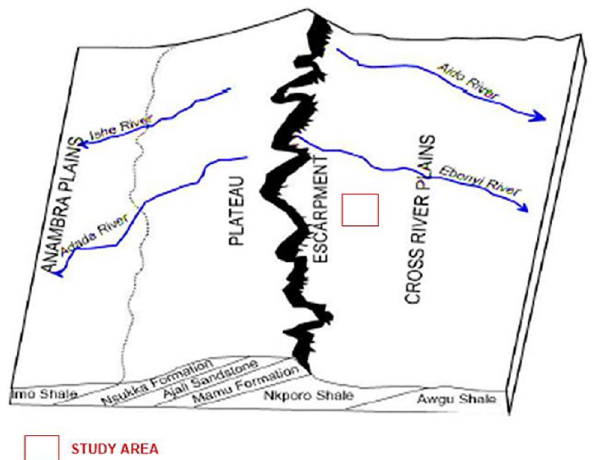
Fig. 5 Physiographic provinces of the study area (After Ofomata, 1978) Not drawn to scale